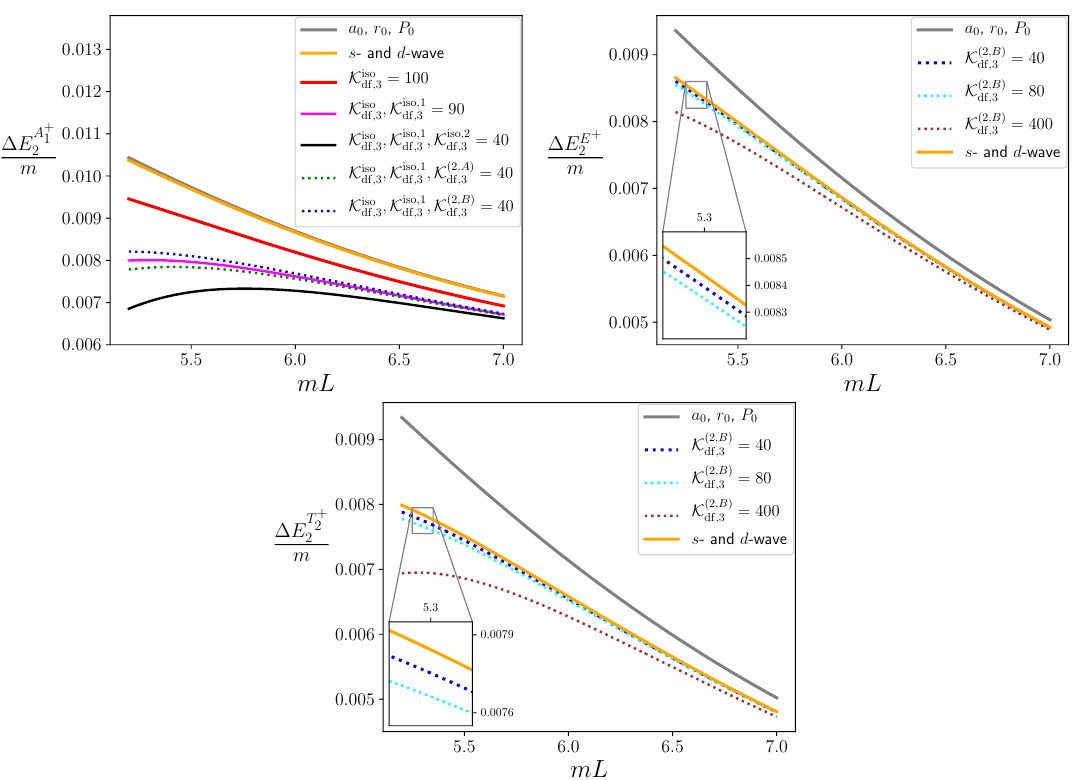
Figure 8. Energy shift of the second excited states in the A + right) and T + irrep (bottom). The meaning of the legend is as in previous (cid:12)gures. 2